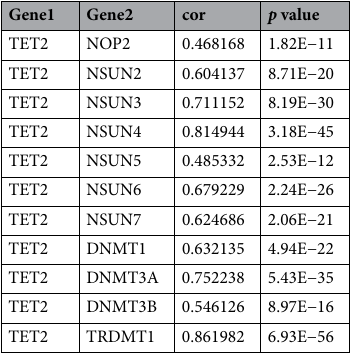
Table 1. The correlation results between erasers and writers.